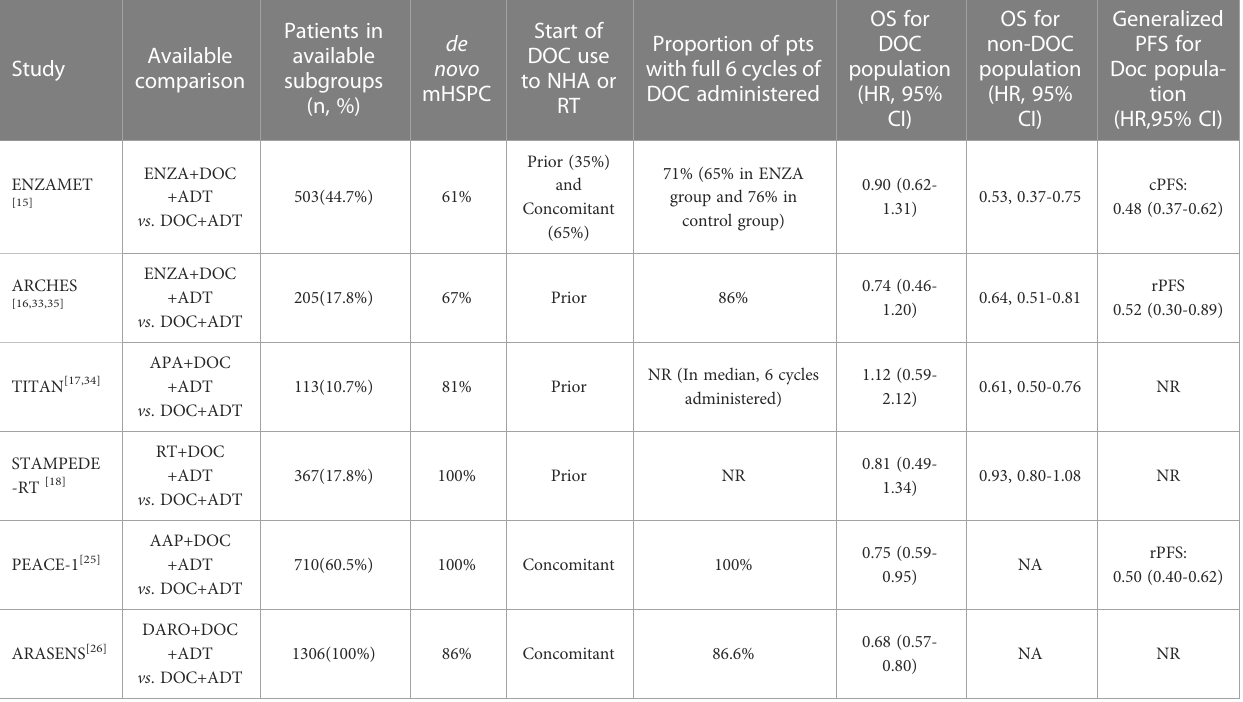
AAP:abirateroneandprednisone;ADT:androgendeprivationtherapy;APA:apalutamide;CI:con fi denceinterval;cPFS:clinicalprogressionfreesurvival;DARO:darolutamide;DOC:docetaxel; ENZA: enzalutamide; HR: hazard ratio; NA: not applicable; NHA: novel hormonal agent; NR: not reported; PFS: progression free survival; rPFS: radiographic progression free survival; RT: